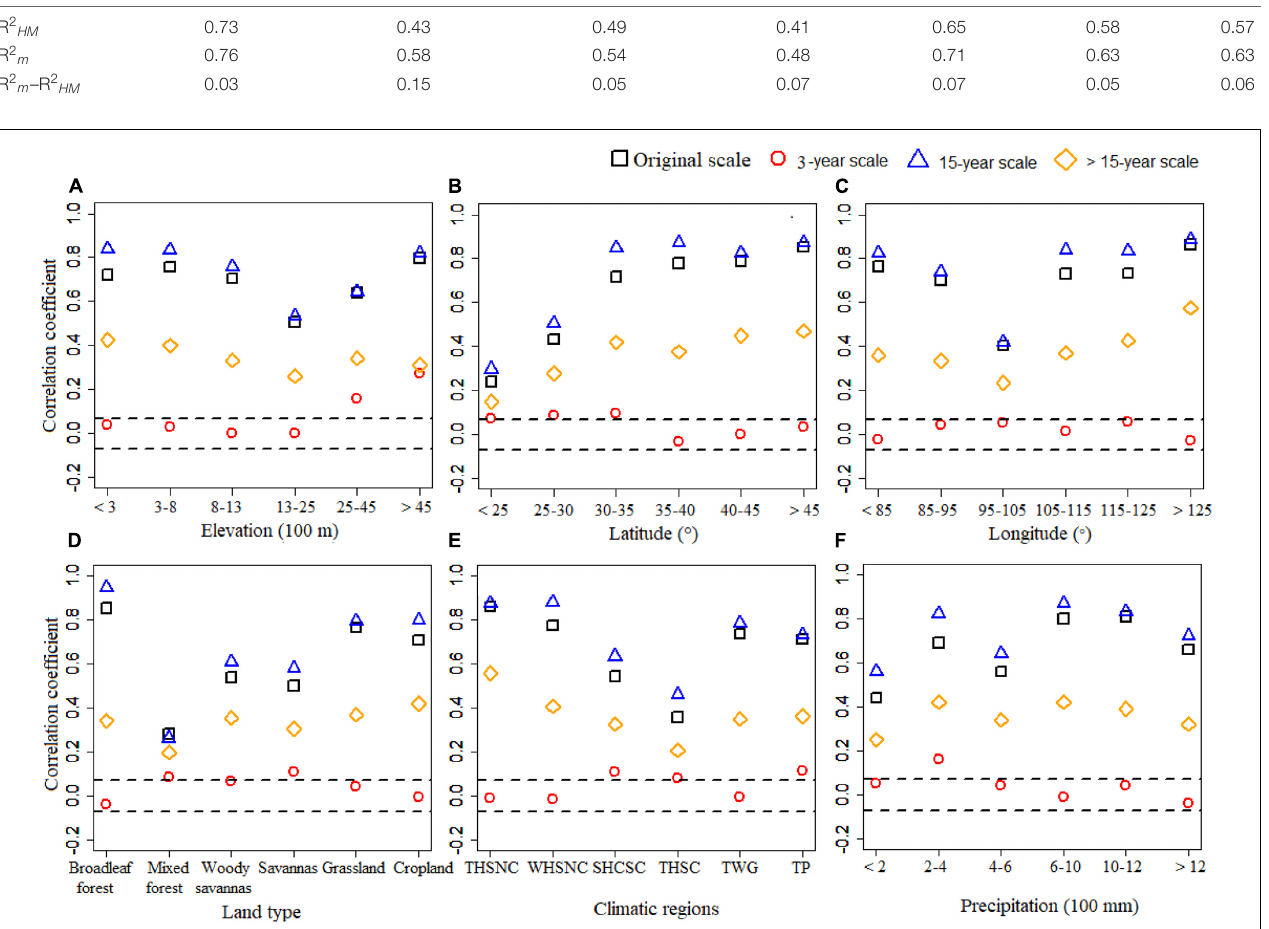
FIGURE 4 | Temporal correlation between NDVI and daily mean temperature (DMT) under different (A) elevation, (B) latitude, (C) longitude, (D) land type, (E) climatic regions, and (F) precipitation at the original scale and multiple temporal scales. NDVI, normalized difference vegetation index.